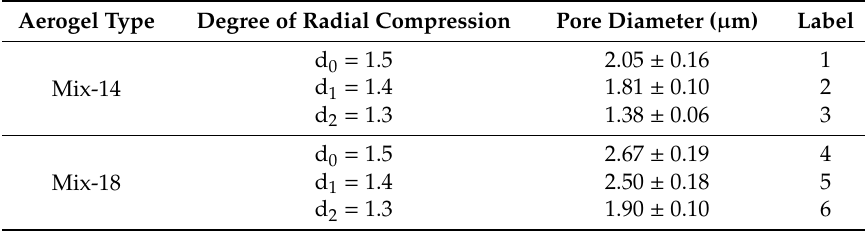
Figure 2. SEM images of SSMPA unrestricted (control or d 0 = 1.5 cm) and different degrees of radial compression (d 1 = 1.4 cm and d 2 = 1.3 cm). SEM images of bare aerogels (i.e., not coated with collagen nor plated with cells). ( a – c ) SSMPA Mix-14 and ( d – f ) SSMPA Mix-18; ( a , d ) unrestricted (control or d 0 = 1.5 cm); ( b , e ) lesser degree of radial compression (d 1 = 1.4 cm); ( c , f ) higher degree of radial compression (d 2 = 1.3 cm). Table 1. Effect of radial compression on SSMPA pore size.